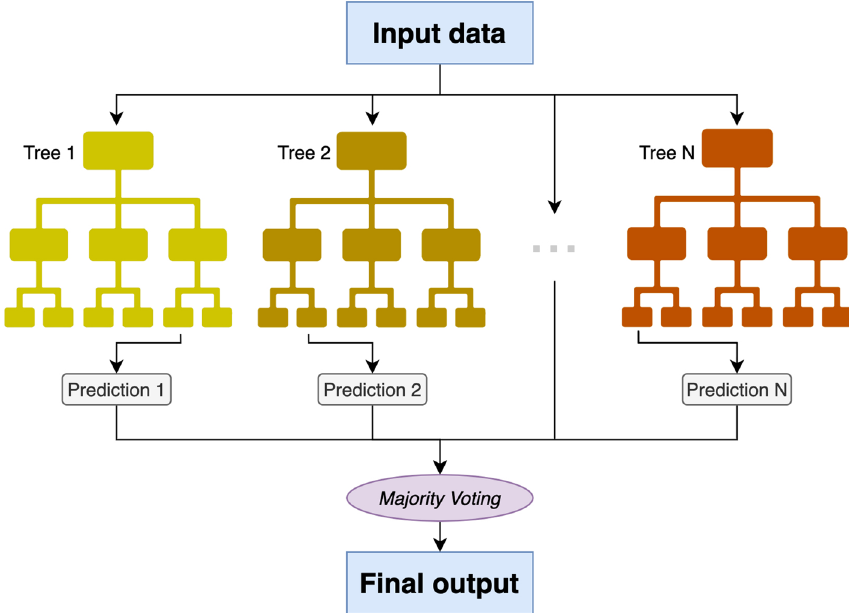
Figure 5. A schematic demonstrating how the final prediction of a random forest classifier is based on input data; N can be any natural number, usually ranging from 50 to 600.